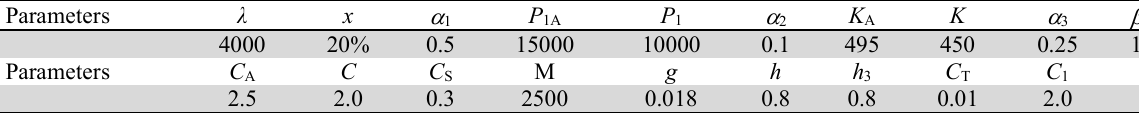
Assumptions of system parameters in the numerical demonstration